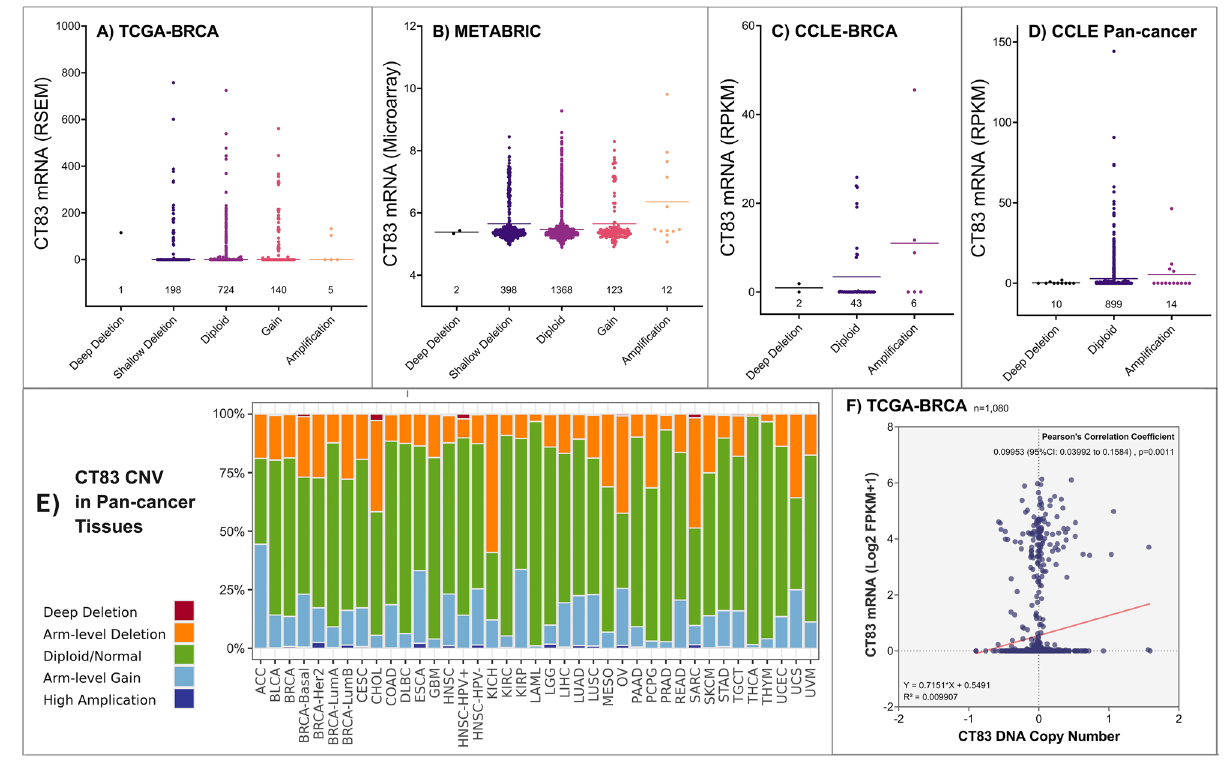
Figure 4. Copy number variations of CT83 in cancer. Copy number variations of CT83 in breast cancer tissues based on data from the TCGA-BRCA ( A ) and the METABRIC ( B ) dataset. Copy number variations of CT83 in breast cancer cell lines ( C ) and pan-cancer cell lines ( D ) based on data from the CCLE dataset. The median expression levels of CT83 mRNA were labeled as dashes. Copy number variations of CT83 in pan-cancer tissues ( E ) based on TCGA cancer data. The correlation between CT83 DNA copy number and CT83 mRNA expression levels ( F